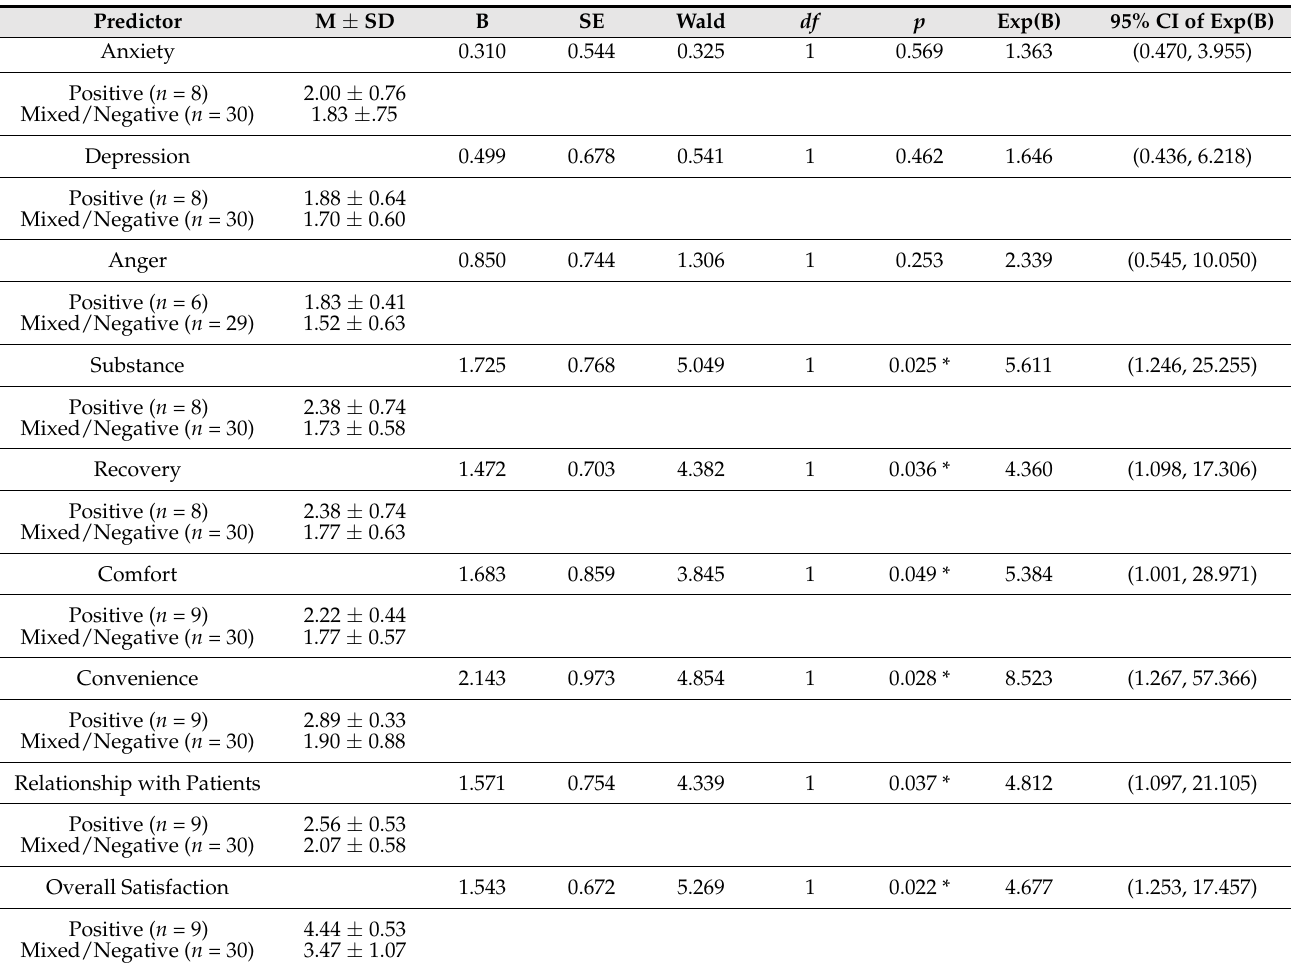
Table 2. Logistic regression results comparing study variables with valency (Positive = 1, Mixed/Negative = 0). Predictor